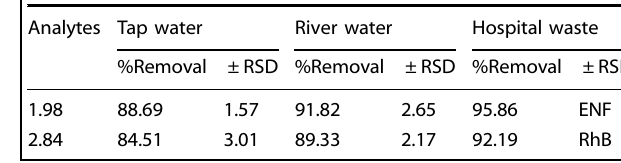
Table 4. %Removal and RSD in different water samples ( N = 3).